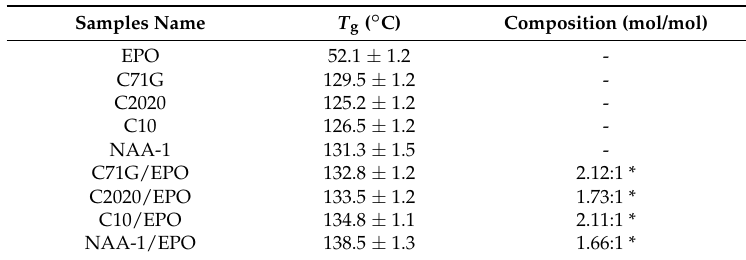
Table 4. Main physical features, namely hydrodynamic diameter ( D h ), zeta potential ( ζ ), and mucoadhesive properties of placebo IPECs. The value in the brackets refers to the percentage of the main population.